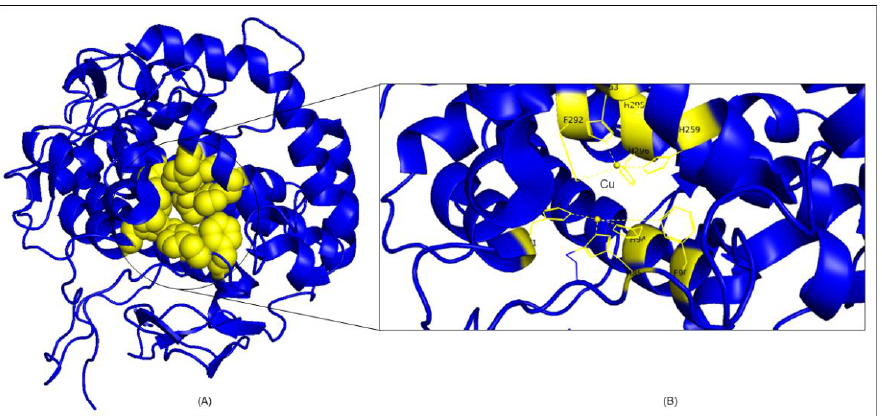
Figure 7. Ligand binding pocket studies. ( A ) Cartoon representation of PPO3 tyrosinase PDB ID: 2Y9X (blue) shows the catalytic sites in sphere shape (yellow). ( B ) Nearby copper (Cu) atom residues are involved in various catalytic activities.